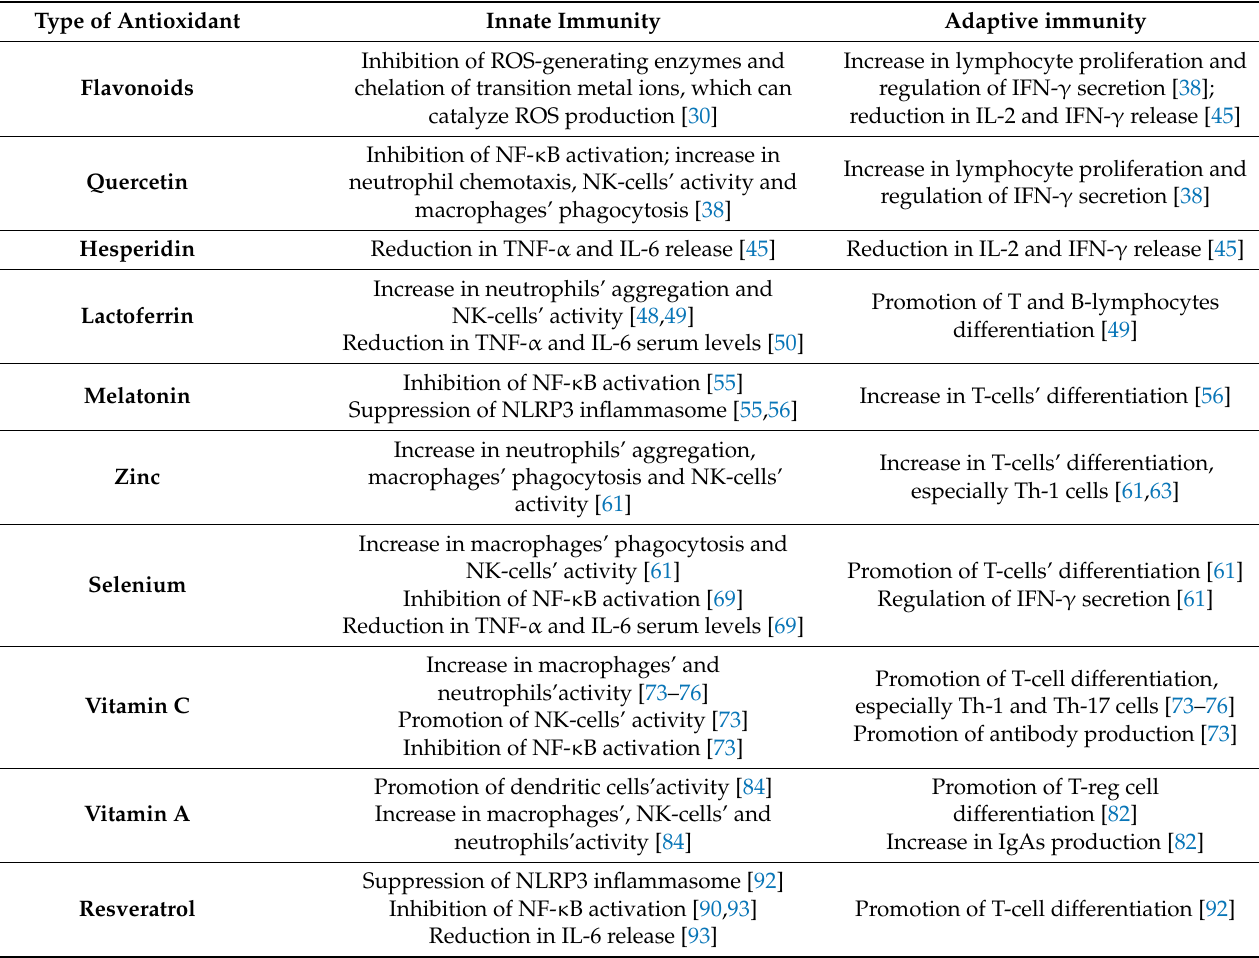
Table A1. Influence of antioxidants on the immune